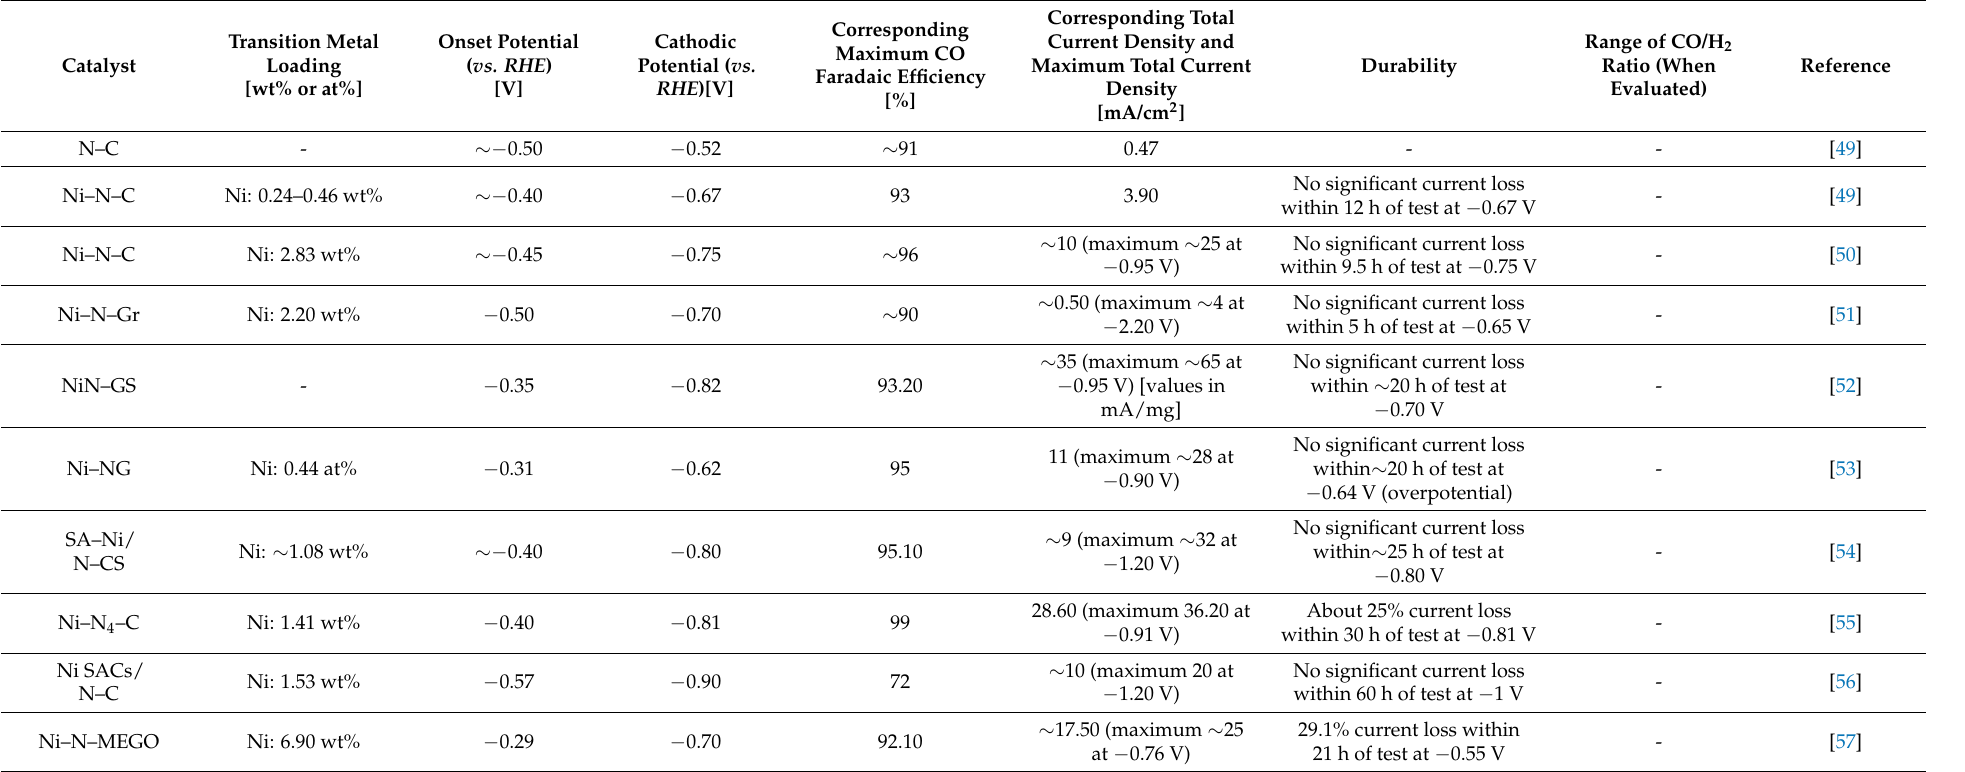
Table 2. Evaluation parameters of the most recent metal SACs for the CO and syngas electro-production from CO 2 in aqueous electrolyte solution at ambient pressure and